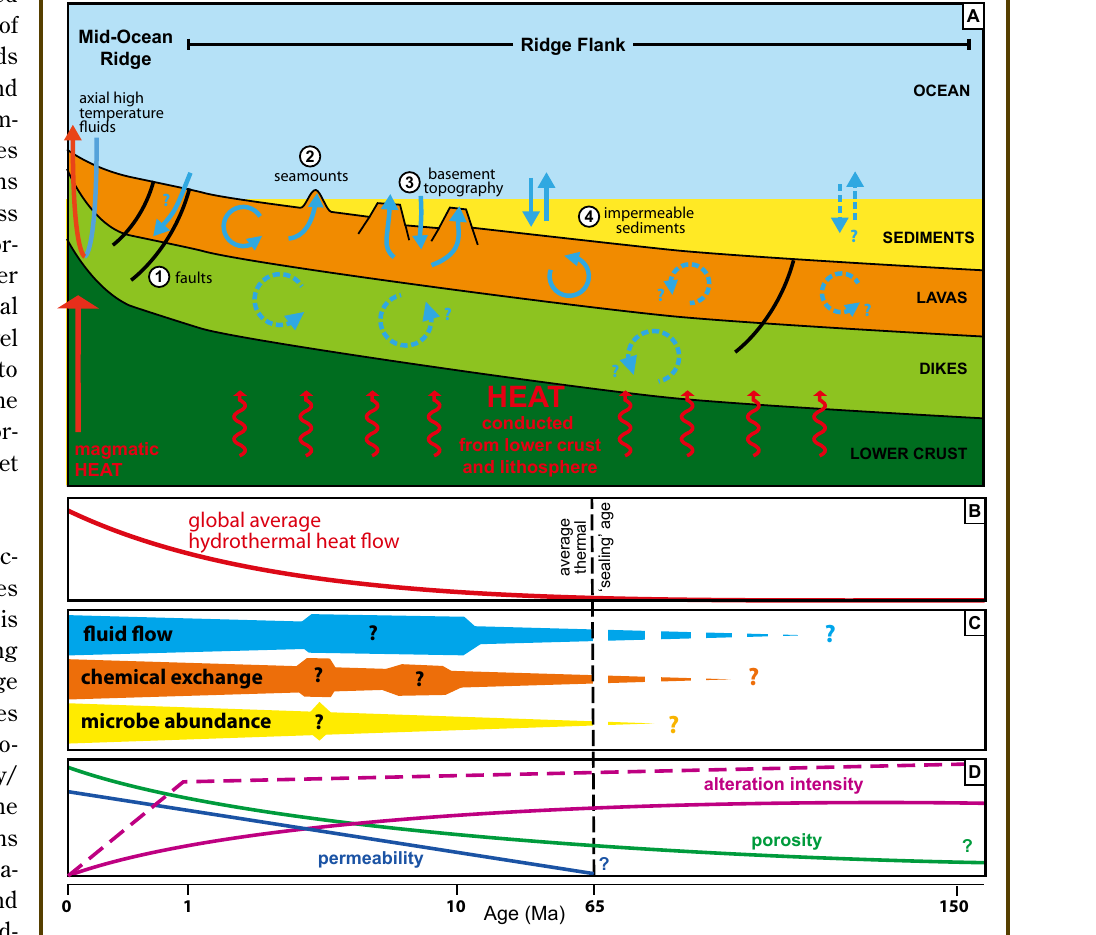
Figure 2. Diagram showing the predicted changes in crustal properties during aging (from Teagle et al., 2009). [A] Parameters that may influence the intensity and style of hydrothermal circulation through the ridge flanks, such as faults, seamounts, basement topography and impermeable sediments. Arrows indicate heat (red) and fluid (blue) flow. [B] The difference between the average measured conductive heat flow and that predicted from conductive cooling plate models. The calculated global hydrothermal heat flow decreases to zero, on average, by 65 Ma. At this age the crust is typically assumed to be ‘sealed’ to hydrothermal circulation. [C] How parameters such as basement topography and sediment thickness affect fluid-flow, chemical exchange, and microbe abundance in the crust during the aging process remain undetermined. The hydrological, physical, chemical, and biological evolution of hydrothermal circulation through the ridge flank could be investigated across a ridge flank. [D] The controls on the intensity and style of hydrothermal circulation could be investigated by the measurement of multiple parameters such as porosity, permeability, and alteration